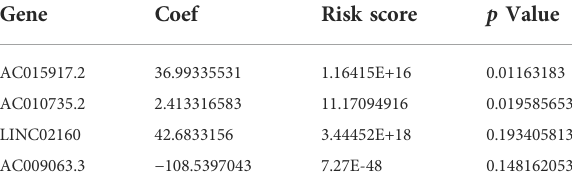
TABLE 3 Multivariate COX modeling